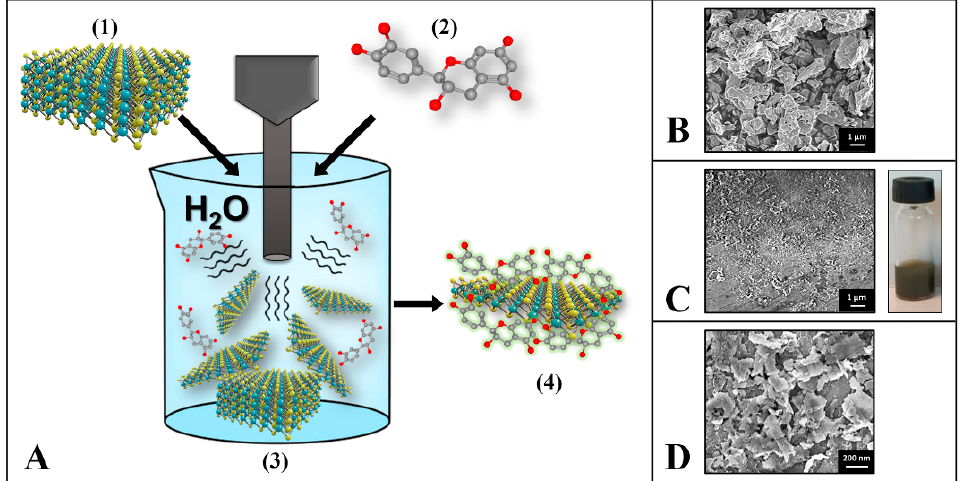
Figure 1. ( A ) Graphical sketch of the MoS 2 sonochemical exfoliation assisted by catechin. (1) Bulk MoS 2 , (2) catechin structure, (3) sonochemical exfoliation process, (4) MoS 2 /CT nanoflakes. ( B ) SEM micrograph of the bulk-MoS 2 (unexfoliated); ( C ) SEM micrograph of the exfoliated MoS 2 /CT (left); picture of the MoS 2 -CT colloidal water-dispersion (right). ( D ) SEM magnification of the MoS 2 /CT nanoflakes.